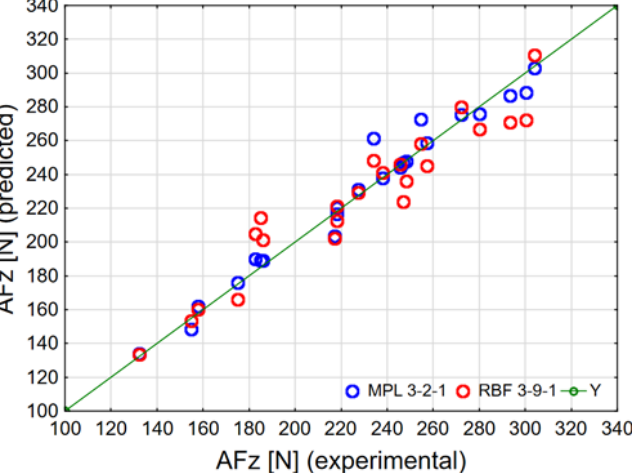
Figure 15. Correlation graph comparing the modeling and experimental results of the amplitude of cutting-force component F z (AFz).